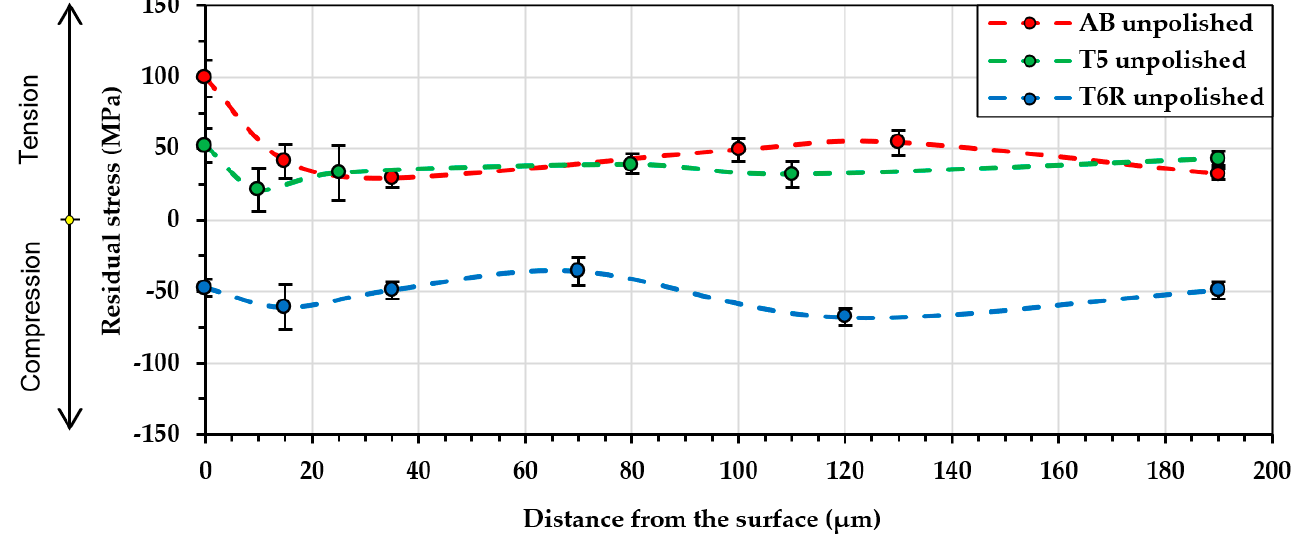
Figure 3. Distribution of residual stresses as a function of the distance from the unpolished surface of the AB, T5, and T6R.